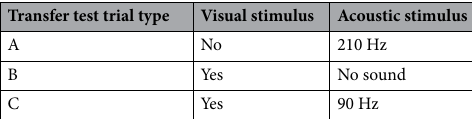
Table 1. Transfer 1 trials—utilized